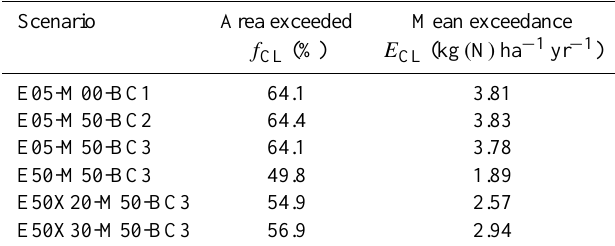
Table 7. Statistics of detailed critical load exceedances in the EU28 + region, EMEP MSC-W model.